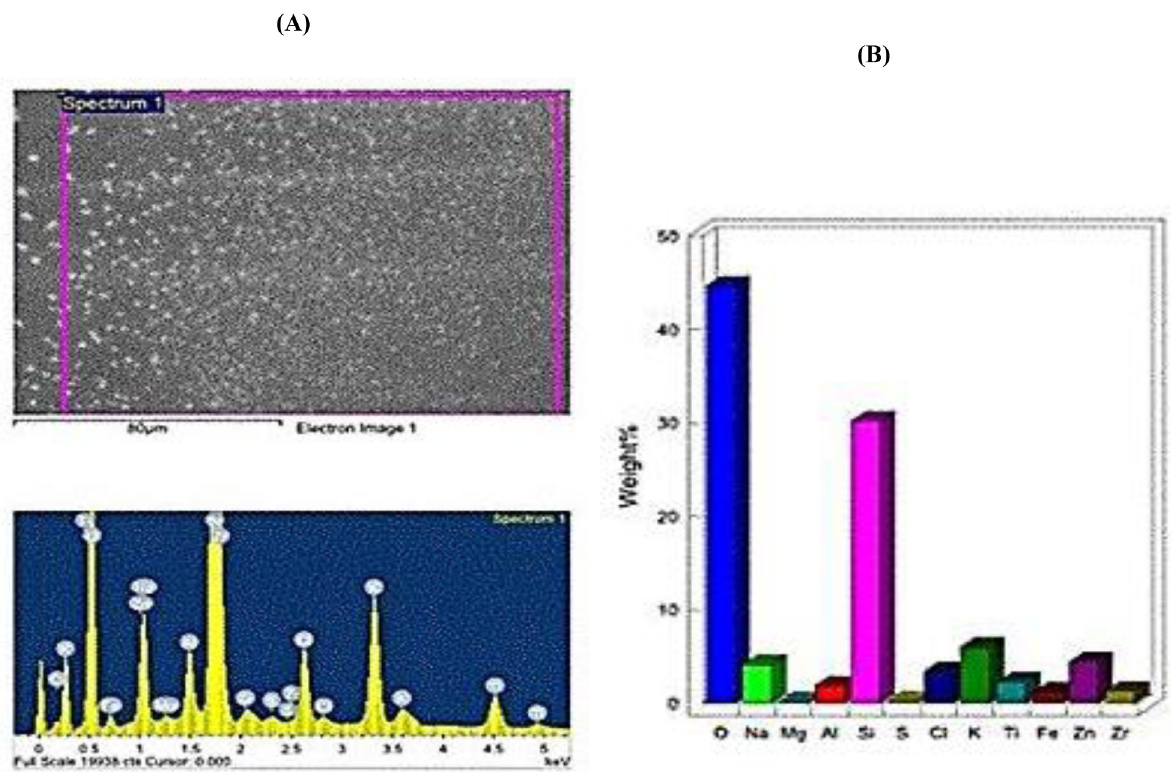
Fig 4. SEM-EDX images (A) and the corresponding element analysis images (B) of (IONPs) obtained from S . costus root extracts.